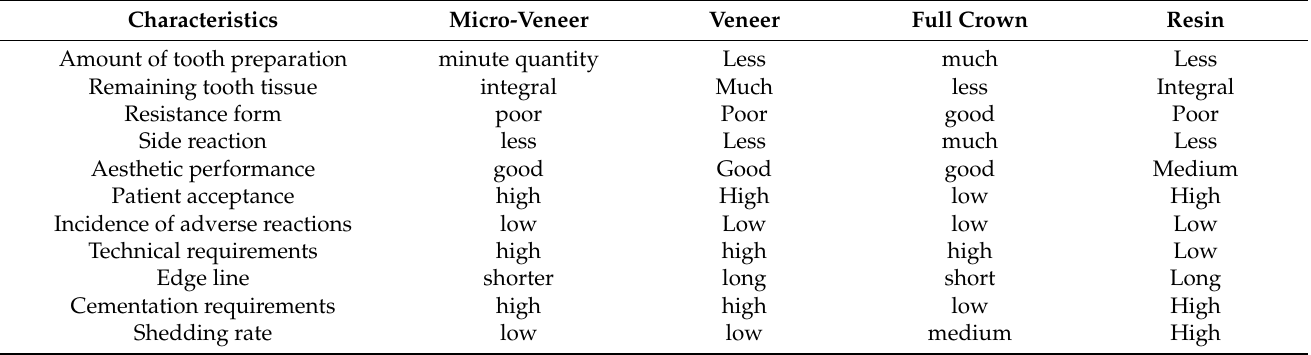
Table 3. The characteristics of four restoration methods: are resin, full crown, veneer, and micro-veneer.